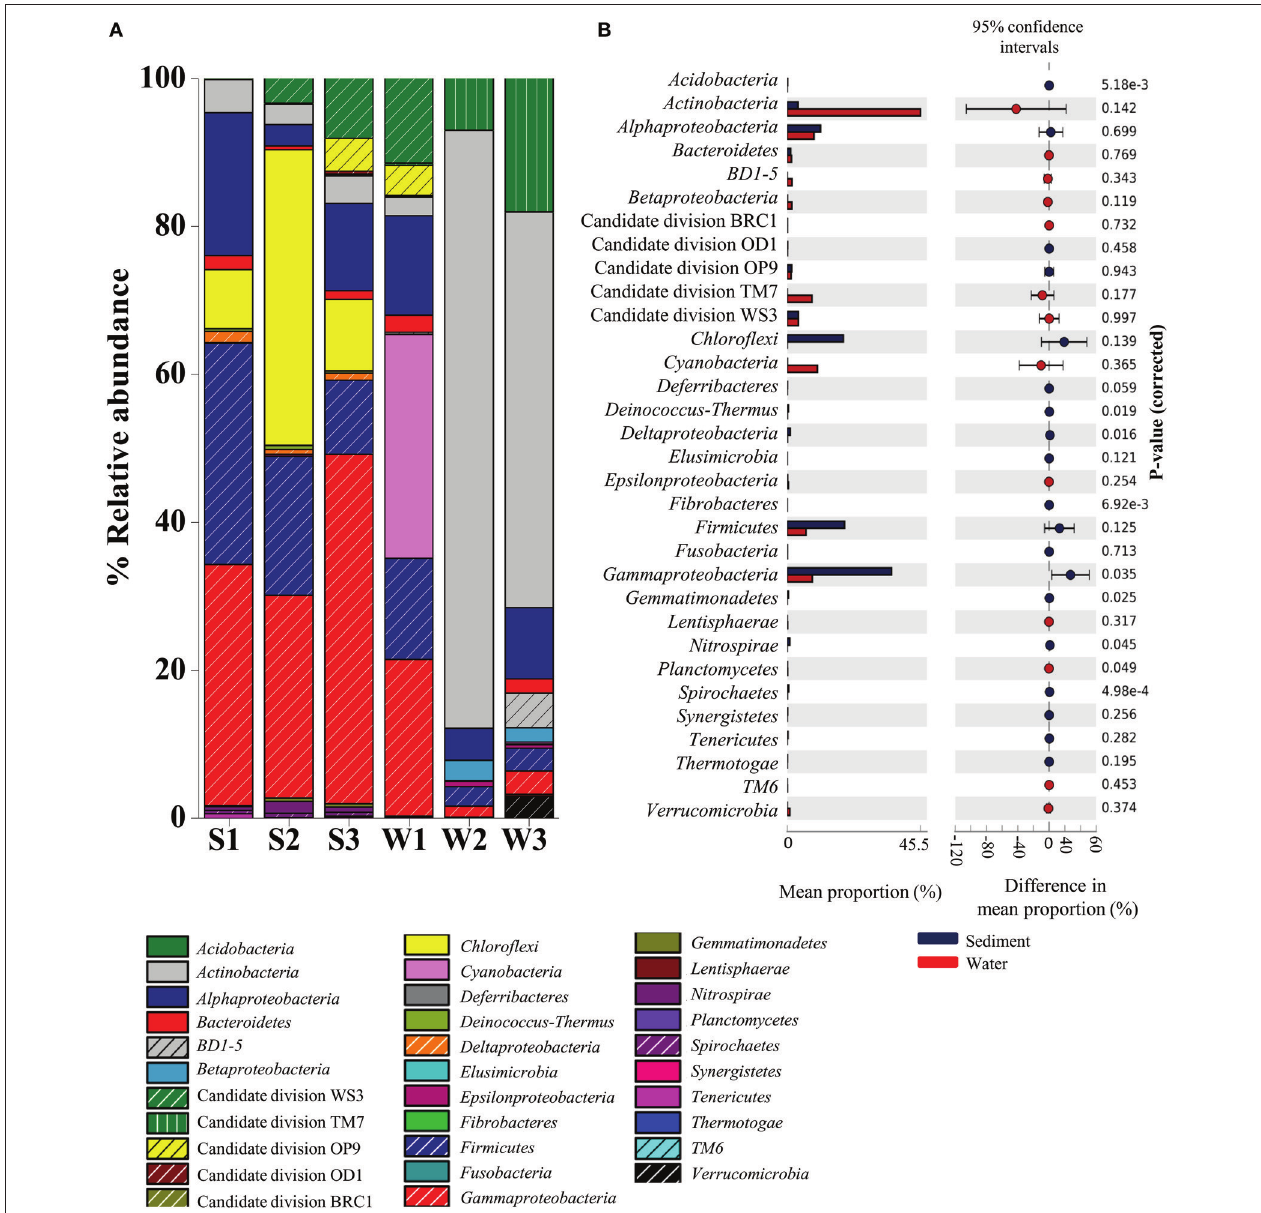
FIGURE 1 | Distribution of major phylogenetic groups of bacteria in (A) across the sediment and water samples, and (B) overall distribution between sediment and water samples of the Lonar Lake. Bacterial abundance in the sediment sample has a positive difference between proportions (blue circles), whereas bacterial abundance in the water sample has a negative difference between proportions (red circles). Bars on the left represent the proportion of each bacterial phyla abundance in the samples. Bacterial abundance difference with a p- value of > 0.05 were considered to be